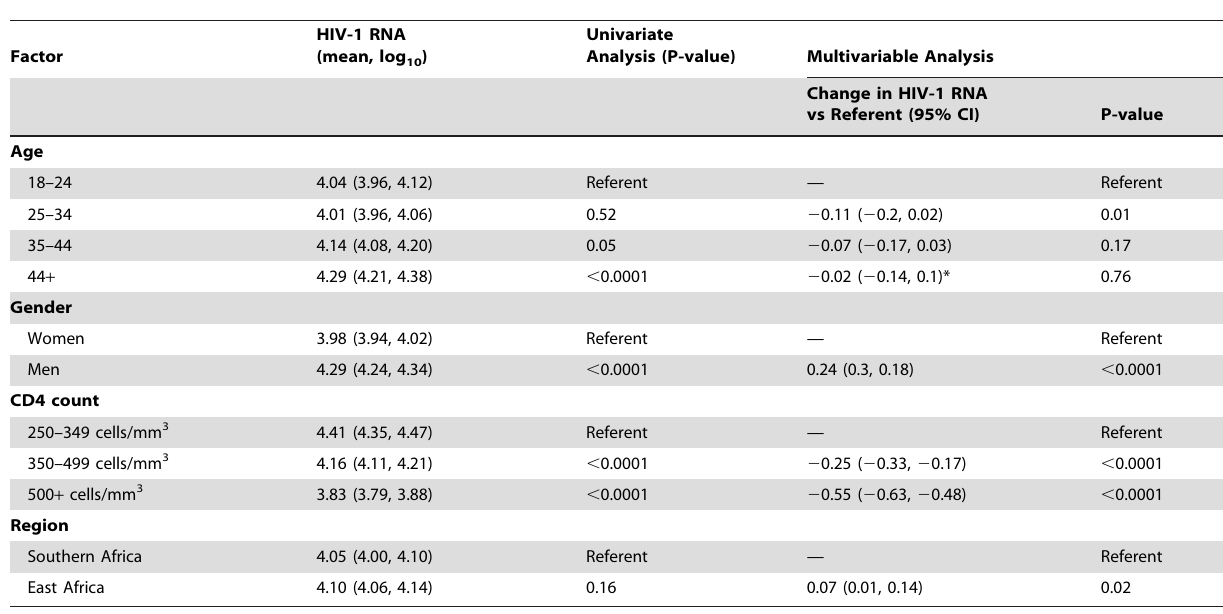
Table 5. Determinants of Baseline Plasma RNA in Partners Study HIV-1 Discordant